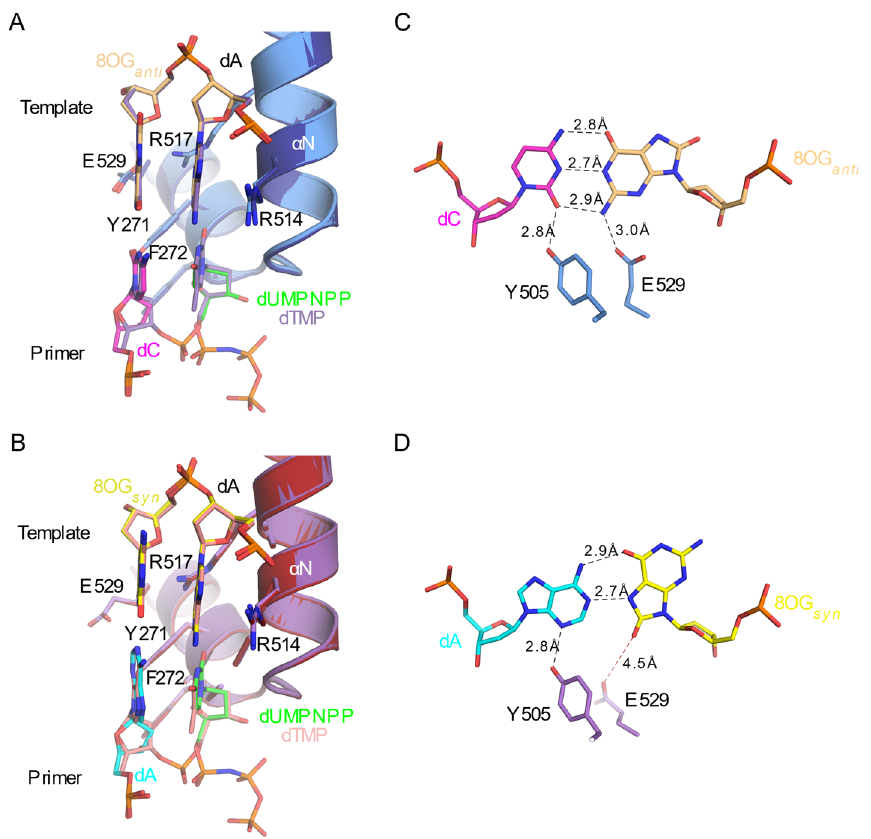
Figure 7. Extension from a template 8OG opposite the primer terminus by Polλ. ( A ). Superpositions of the pre- (protein in light blue, DNA in light orange, primer terminal dC in magenta, and incoming dUMPNPP in green, PDB ID code 5IIN [34]) and post-catalytic (protein in dark blue, DNA in purple, PDB ID code 5IIK [34]) complexes of dC:8OG anti bound to Polλ. ( B ). Superpositions of the pre- (protein in purple, DNA in yellow, primer terminal dA in cyan, and incoming dUMPNPP in green, PDB ID code 5IIM [34]) and post-catalytic (protein in maroon, DNA in pink, PDB ID code 5IIL [34]) complexes of dA:8OG syn bound to Polλ. Comparisons of the primer terminal base pairing and interactions with either the dC:8OG anti ( C ) or dA:8OG syn ( D ) primer termini. Nucleotides and protein side chains are colored as in ( A ) or ( B ), respectively. Hydrogen bonding interactions and their respective distances are shown as black dashed lines. The Glu529 interaction with the 8OG base that is lost in the syn conformation is indicated by the red dashed line.